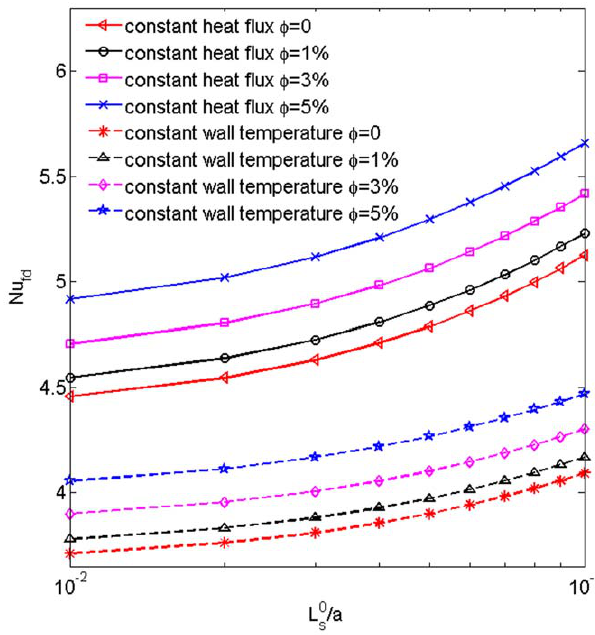
different boundary conditions. The thermally fully developed Nusselt numbers for w ~ 0, 1%, 3% and 5% as a function of the slip length with both constant wall temperature and constant heat flux boundary conditions are compared.